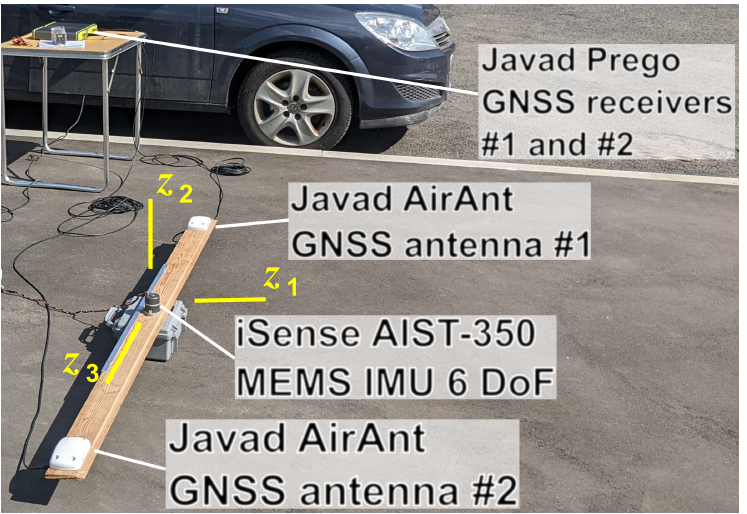
Figure 6. An experimental setup used for preliminary validation of the calibration method. Two GNSS antennas and a 6 DoF MEMS IMU are fixed to a single base plank. After initial alignment, the whole structure undergoes series of rotations of different types performed by